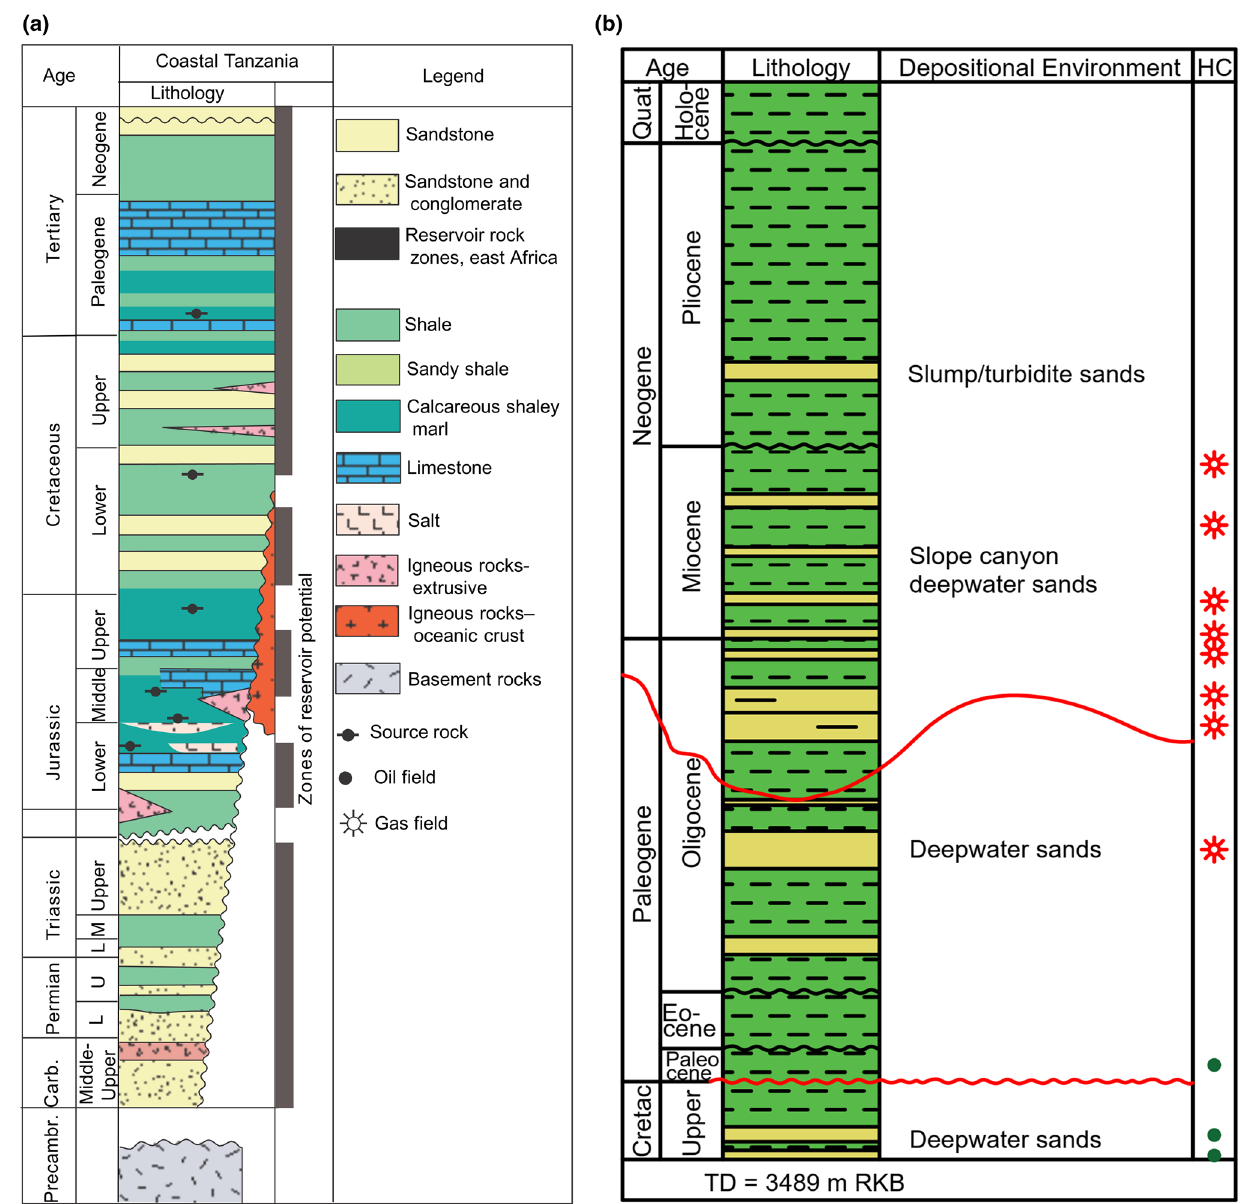
Fig. 1 a Regional stratigraphy of the R reservoir and b cross section of the well R – X showing lithology and age. Modified from RPS